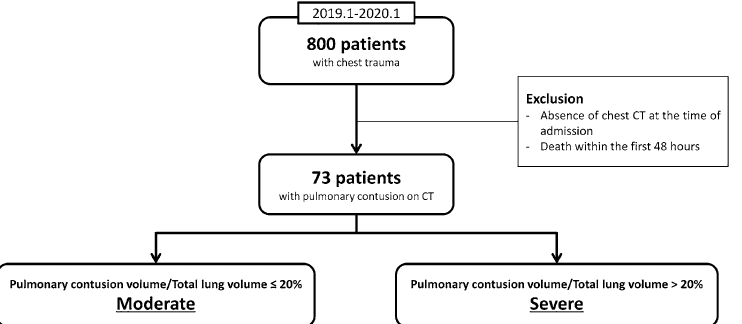
Figure 1. Study design flow chart. CT computed